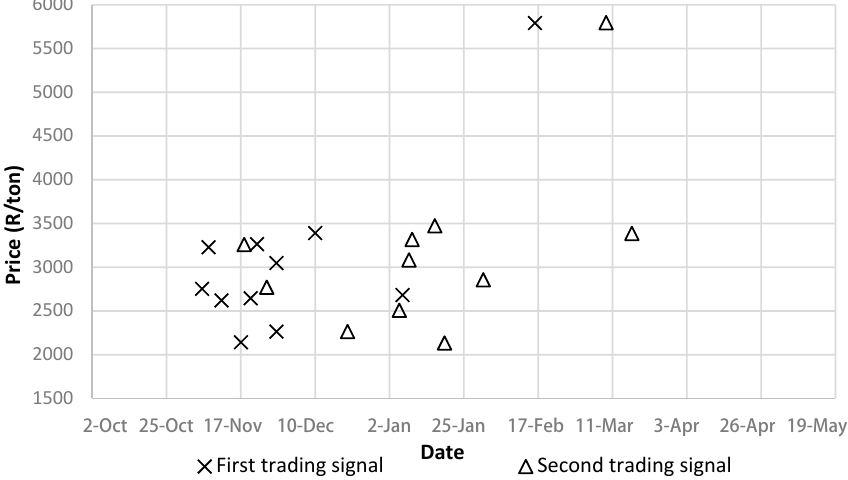
Figure 4. Timing of sales during the 11 marketing years for a risk-neutral decision maker using the MAC 26-6 marketing strategy. Source: Author’s compilation.